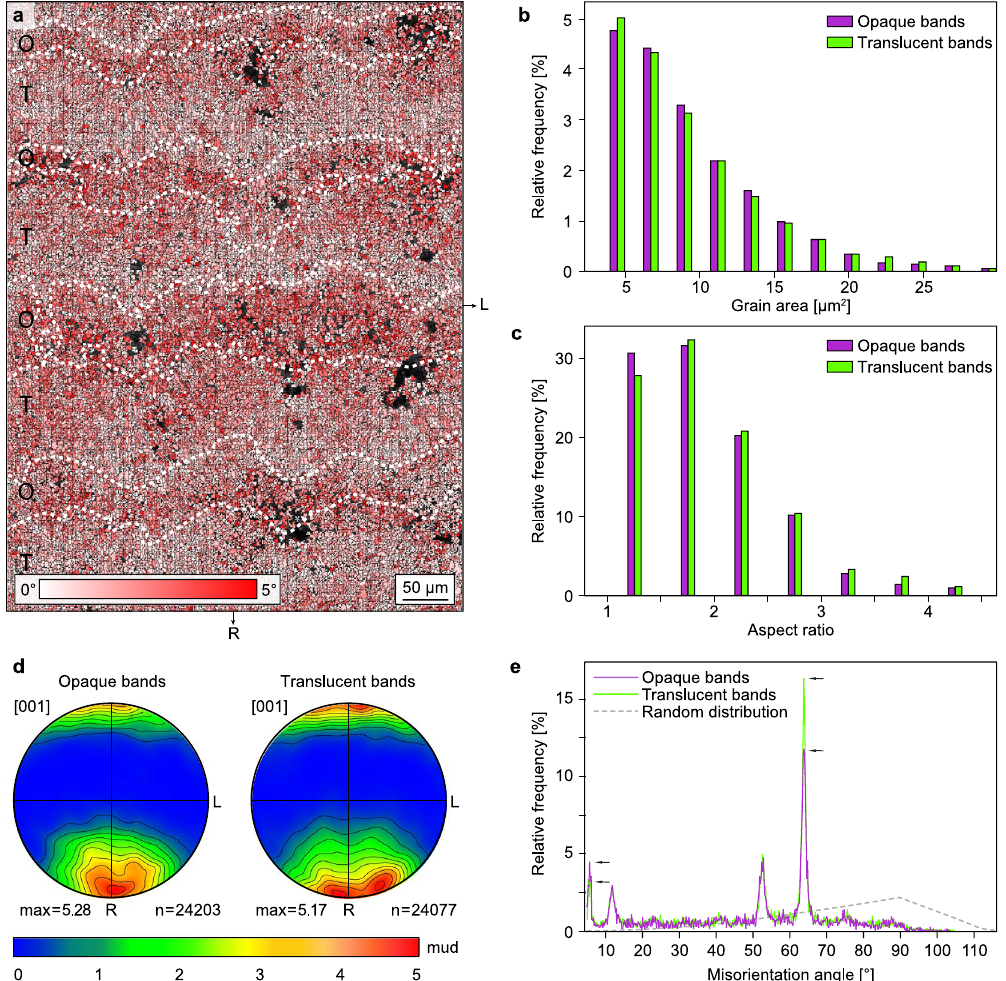
Figure 5. Specific crystallographic misorientations in opaque and translucent bands. ( a ) EBSD local misorientation map of the area squared in Fig. 2 and shown in Fig. 4a. Only misorientations < 5° were considered in this map. A pixel is coloured in red when its average misorientation with respect to the 11 × 11 surrounding pixels is close to 5°. A pixel is coloured in white when its average misorientation with respect to the 11 × 11 surrounding pixels is close to 0°. The map shows a higher abundance of red pixels in opaque bands (O) and of white pixels in translucent bands (T). ( b ) Histogram displaying the grain area distribution for opaque and translucent bands. Crystallites represented by a single pixel (2.25 μ m 2 ) have been discarded for clarity. ( c ) Histogram showing the aspect ratio distribution for opaque and translucent bands. ( d ) Pole figures of aragonite [001] axes showing the crystallographic preferred orientation of [001] axes for opaque and translucent bands. Note that [001] axes in opaque bands have a single crystallographic preferred orientation parallel to R, whereas two maxima are observed in translucent bands. Projection and contouring parameters as in Fig. 4. ( e ) Diagram showing the distribution of misorientation angles between adjacent grains in the opaque and translucent bands. Opaque bands display a lower abundance of misorientation angles of 63.8°, and a higher abundance of misorientations at ~5° (s. arrows), which fits well with the spatial distribution of pixels colour-coded in red in the EBSD map shown in